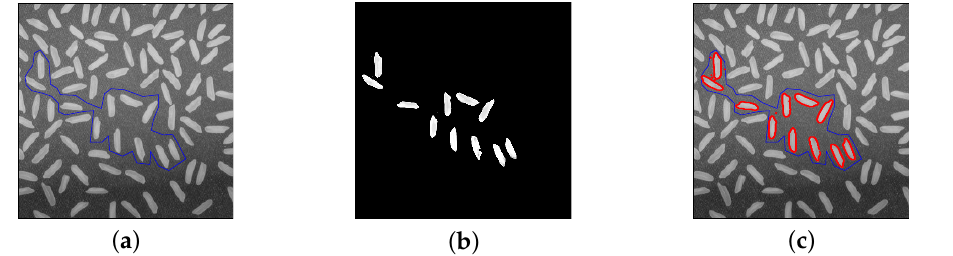
Figure 16. Rice image ( a ) target domain, ( b ) segmented image, and ( c ) segmented contour line with original